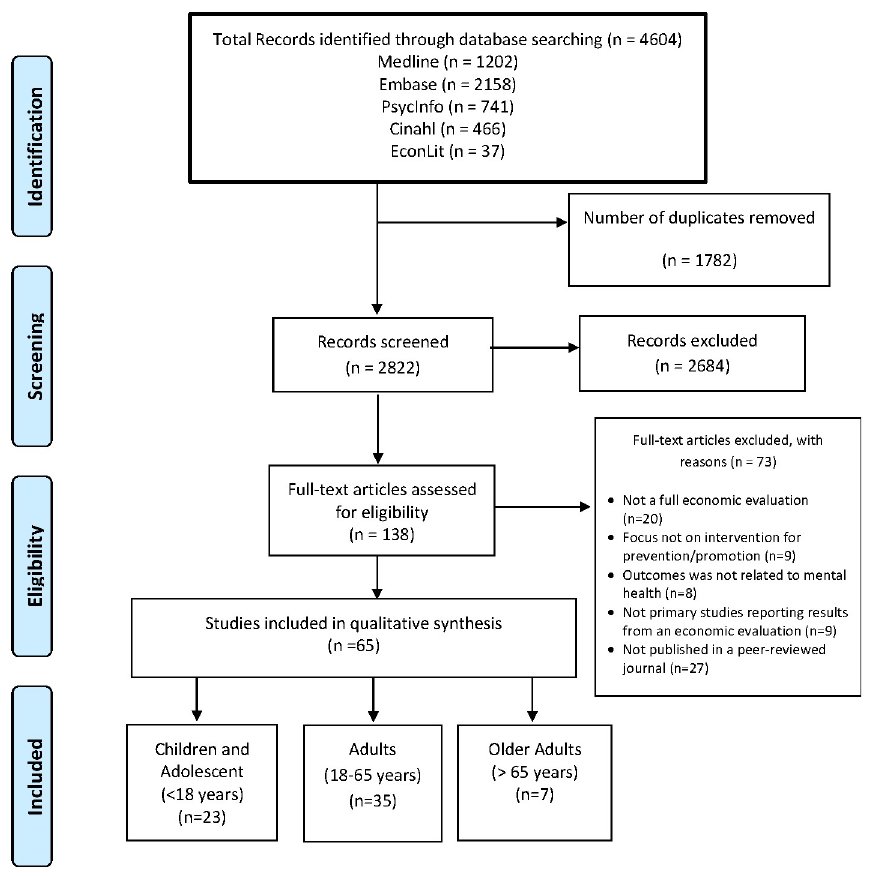
Fig 1. PRISMA flow diagram. PRISMA, Preferred Reporting Items for Systematic Reviews and Meta-Analyses.